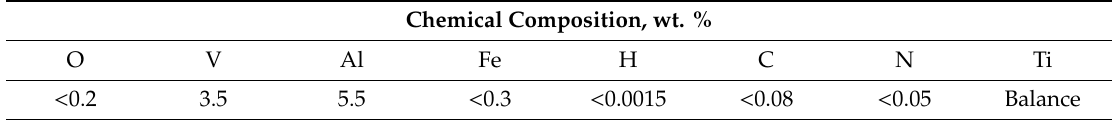
Table 3. Composition of Ti6Al4V [25,36].